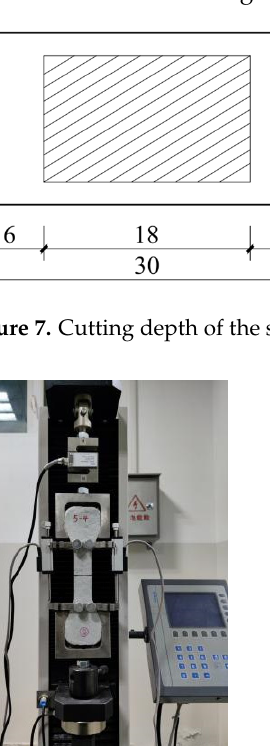
Figure 6. Three-point bending test loading device.